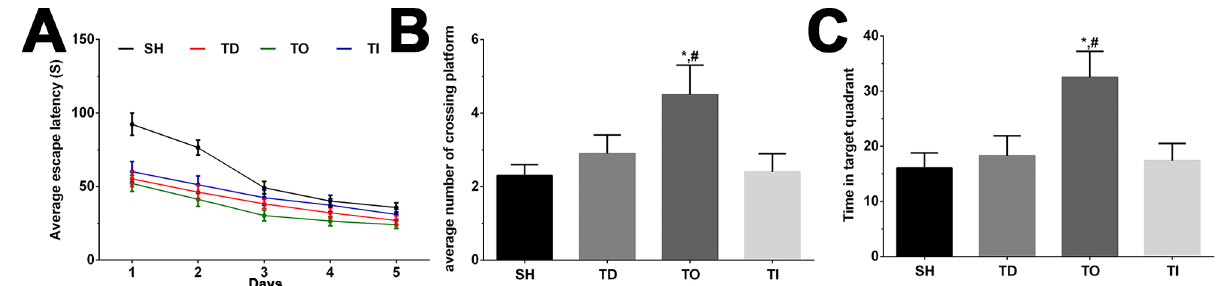
Figure 2 – Detection of memory function using MWM. (A) The escape latency of rats in each group in a continuous 5 days. (B) The average number of crossing platform of rats in each group. (C) The time in target quadrant of rats in each group. Data was presented as mean ± SD. Each experiment was repeated for three times independently. *P<0.05 compared with SH group. #P<0.05 compared with TD group. NC: normal group, DT: dezocine treatment group, DO: dezocine treatment combined with RAPGEF3 overexpression group, DI: dezocine treatment combined with RAPGEF3 inhibition group. SH: sham group, TD: dezocine treatment group, TO: dezocine treatment combined with RAPGEF3 overexpression group, TI: dezocine treatment combined with RAPGEF3 inhibition group.